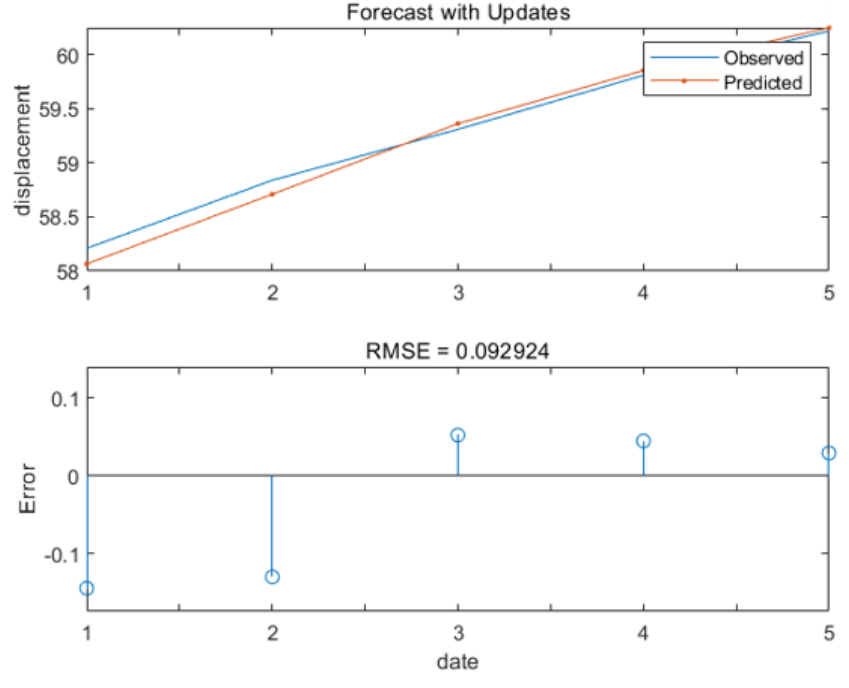
Figure 8. The LSTM prediction effect analysis chart.